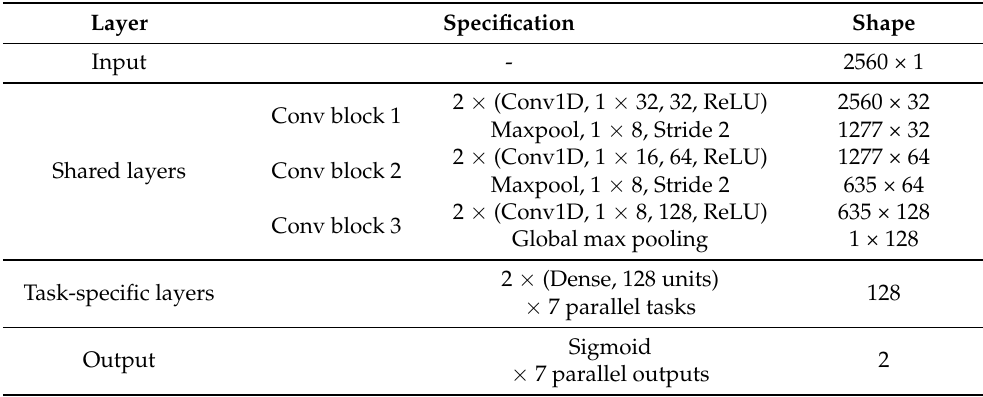
Table 2. Specification of the multi-task deep convolutional neural network that was implemented for self-supervised